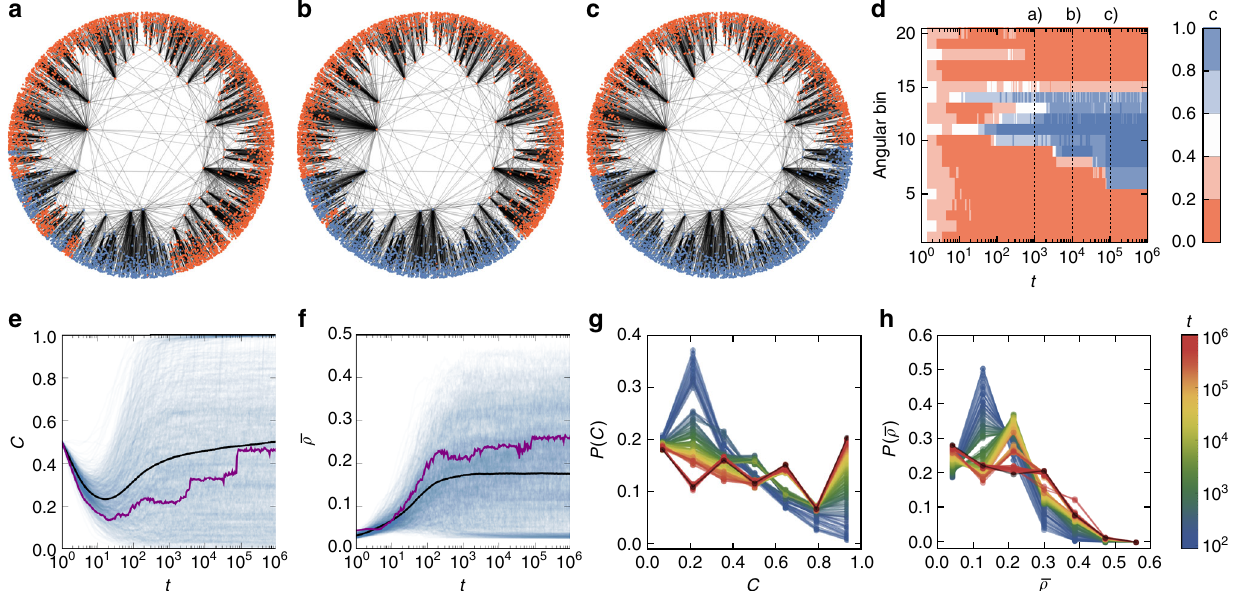
Fig. 2 Spatial patterns in evolutionary games. a – c Evolution of the system (see also Supplementary Movie 1) for a single realization of the prisoner ’ s dilemma ( T = 1.2 and S = − 0.2). Here we have generated a synthetic network with N = 5000 nodes, power law exponent γ = 2.8, and mean local clustering c (cid:2) 0 : 5. Cooperators are marked in blue, whereas red denotes defectors. The system was started with randomly selected cooperators ( c (0) = 0.5). a shows the state of the system after 10 3 , b after 10 4 , and c after 10 5 generations. d Density of cooperators (color coded) in different angular bins (shown on the y axis) as a function of time (shown on the x axis). Here we have divided the angular space θ ∈ [0, 2 π ) into 20 equidistant bins. e – h Results for the same synthetic networks as before but with N = 2 × 10 4 nodes. e Evolution of the density of cooperation C for 10 3 independent realizations of the system (blue lines) and their average (black line). The purple line corresponds to the realization shown in a – c . f Evolution of the KS-statistics ρ for 10 3 independent realizations of the system (blue lines) and their average (black line). The purple line corresponds to the realization shown in a – c . g Evolution of the distribution of cooperation C observed in the system. Each color represents the histogram of cooperation among different realizations of the system at time t , where the color denotes the time (see legend in plot h ). The 7 points hence represent 7 bins. The x -axis denotes the cooperation density C and the y -axis shows the probability P ( C ) that in one realization of the system the density of cooperation at time t is C . h Evolution of the distribution of ρ observed in the system (colors denote